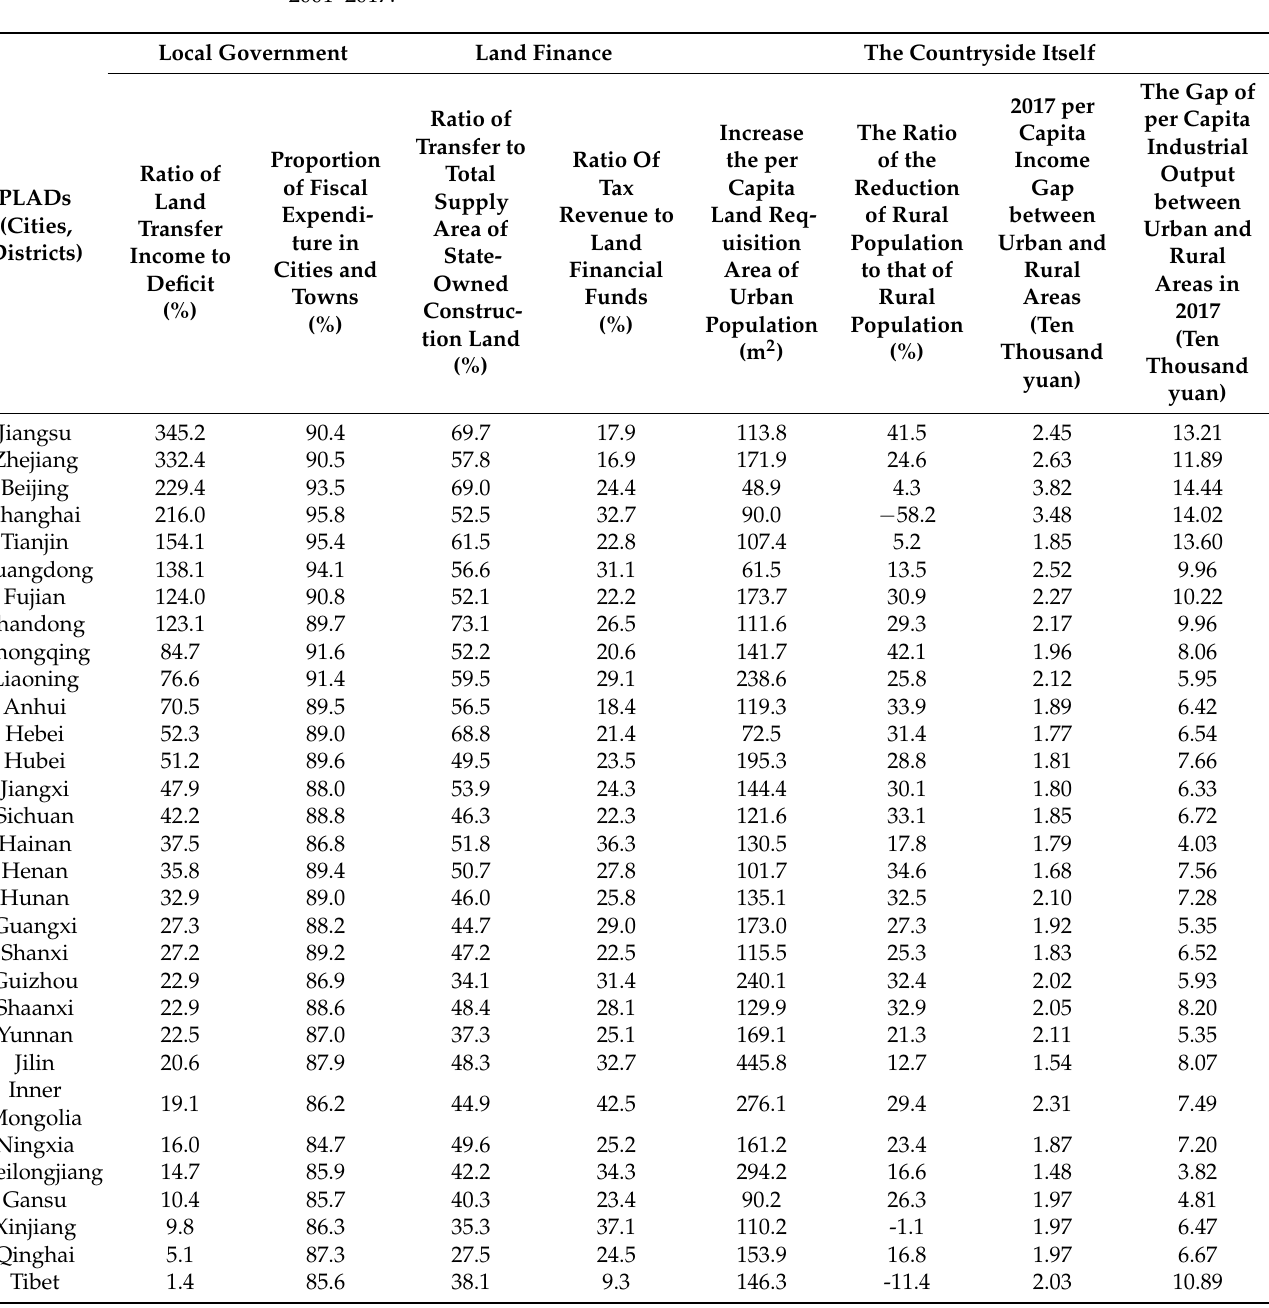
Table 6. Potential obstacle factors of land transfer income supporting rural revitalization in 31 PLADs